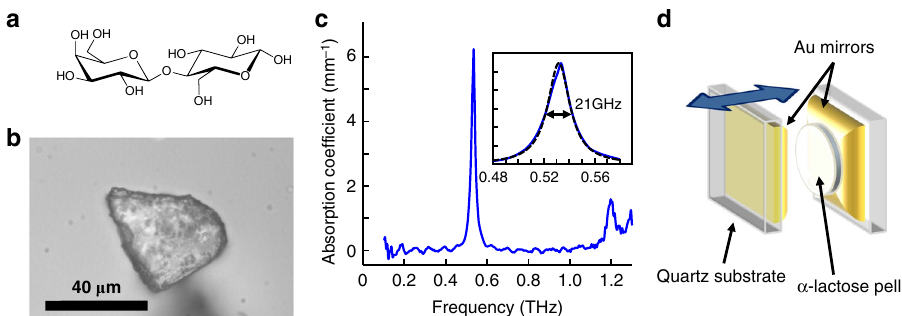
Fig. 1 α -Lactose molecules in a tunable THz cavity . a Chemical structure of α -lactose. b A microscope image of an α -lactose crystallite. c Absorption coef fi cient of the α -lactose pellet obtained from the THz absorption measurement. The inset shows the fi t of the measured absorption peak (blue line) to a lorentzian line-shape (black dashed line). d A sketch of the open THz cavity used in the experiments